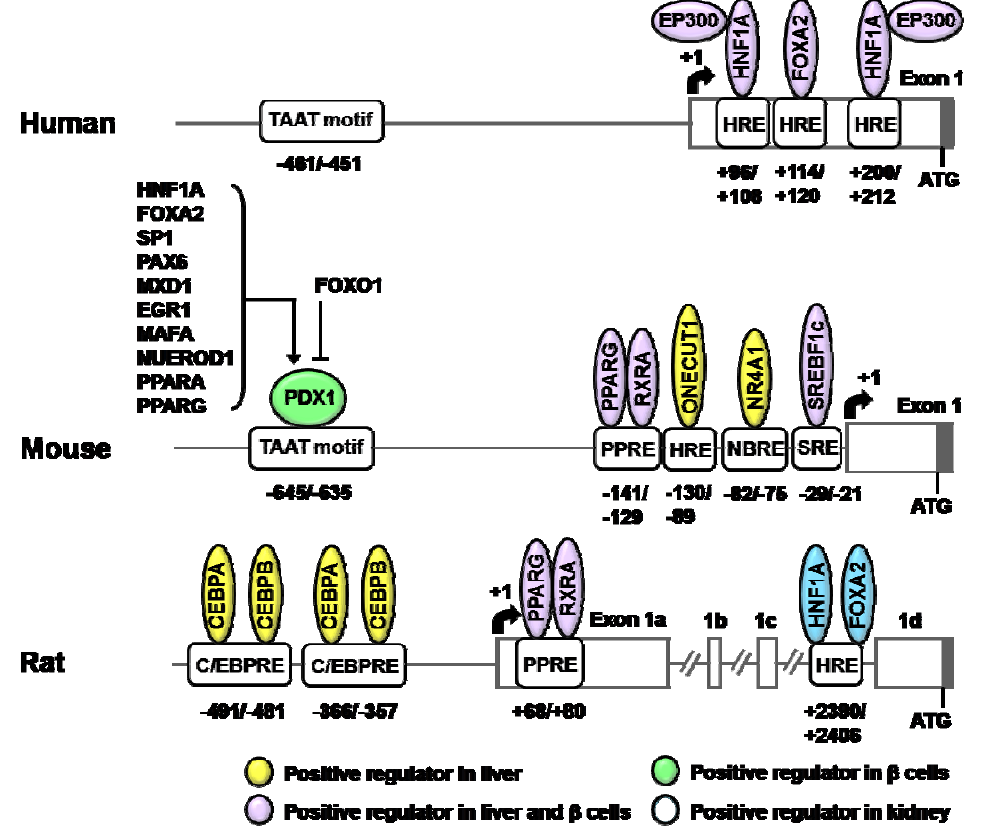
Figure 1. Schematics of transcriptional regulatory elements on the SLC2A2 gene